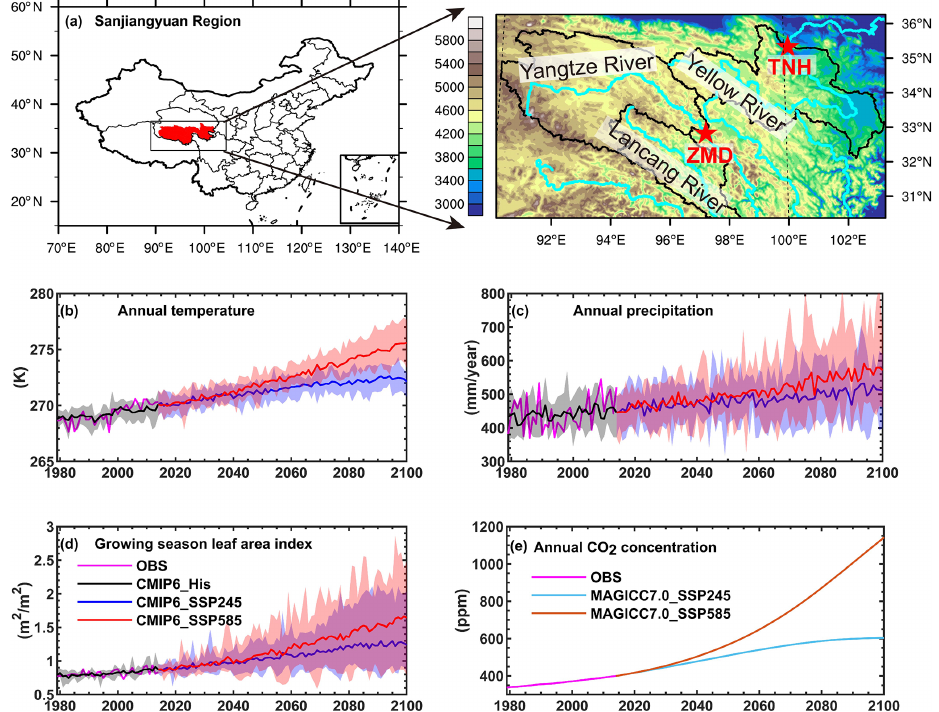
Figure 1. (a) The locations of the Sanjiangyuan region and streamflow gauges. (b–d) The time series of annual temperature, precipitation and growing season leaf area index averaged over the Sanjiangyuan region during 1979–2100. (e) Observed and simulated annual CO 2 concentration over the Sanjiangyuan region. Red stars on the right in (a) are two streamflow stations named Tangnaihai (TNH) and Zhimenda (ZMD). Black, blue and red lines in (b–d) are ensemble means of CMIP6 model simulations from the historical, SSP245 and SSP585 experiments. Shadings show the ranges of individual ensemble members. Cyan and brown lines in (e) are future CO 2 concentration under SSP245 and SSP585 scenarios simulated by the MAGICC7.0